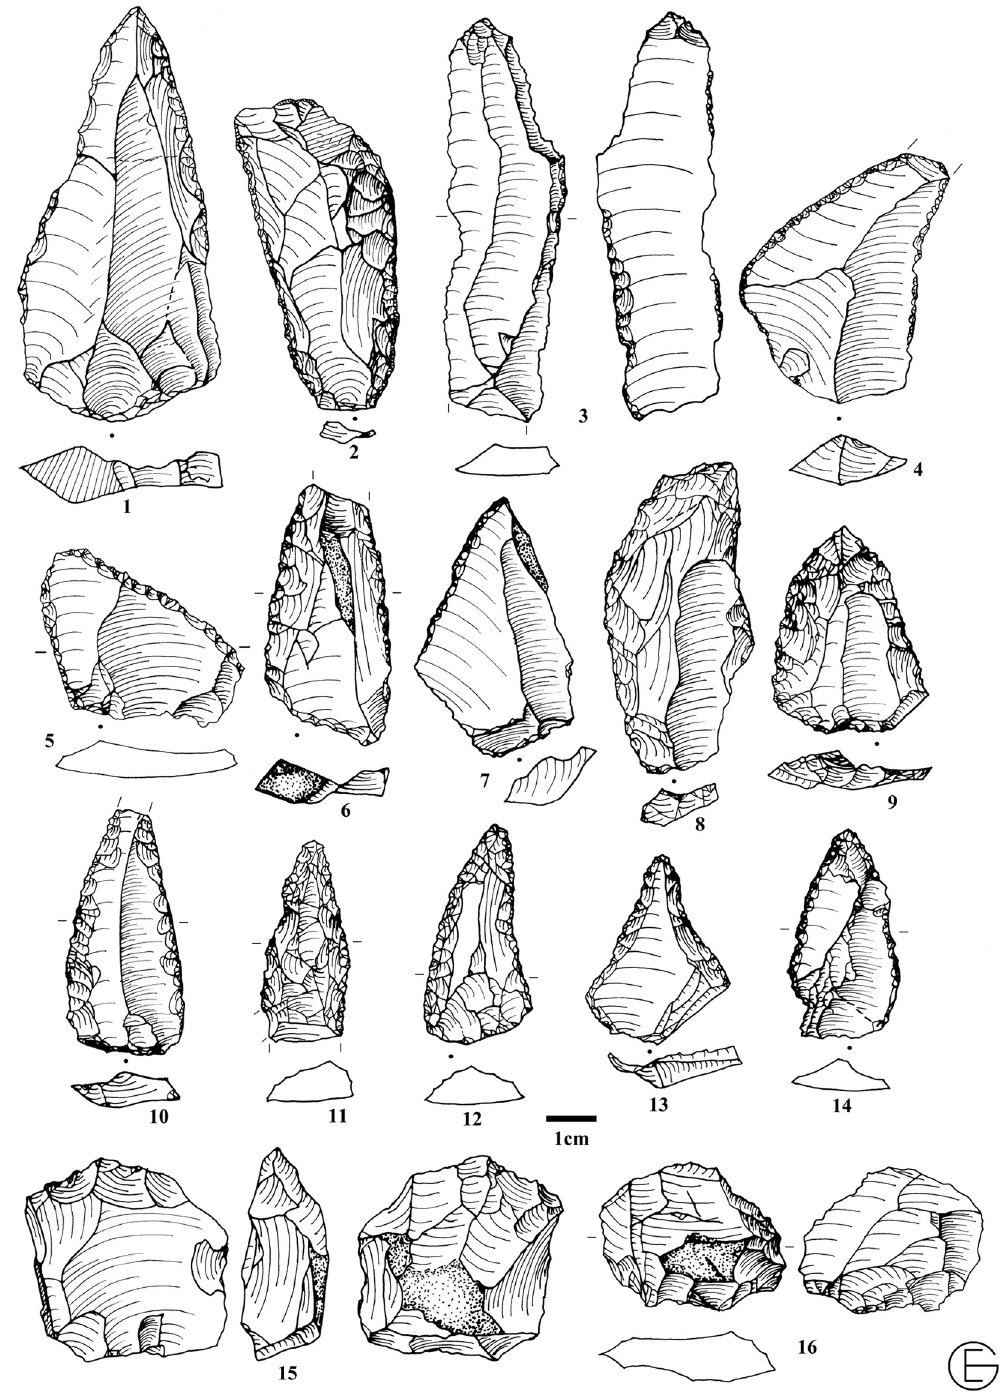
Fig 6. A sample of the Zagros Mousterian artifices from the Bawa Yawan rockshelter around the BY 1. 1, 9–14. Convergent scraper, 2,6. Double scraper, 3. Denticulate, 4, 5. Dejete scraper, 7. Single scraper, 8. Scraper, 15, 16. Truncated